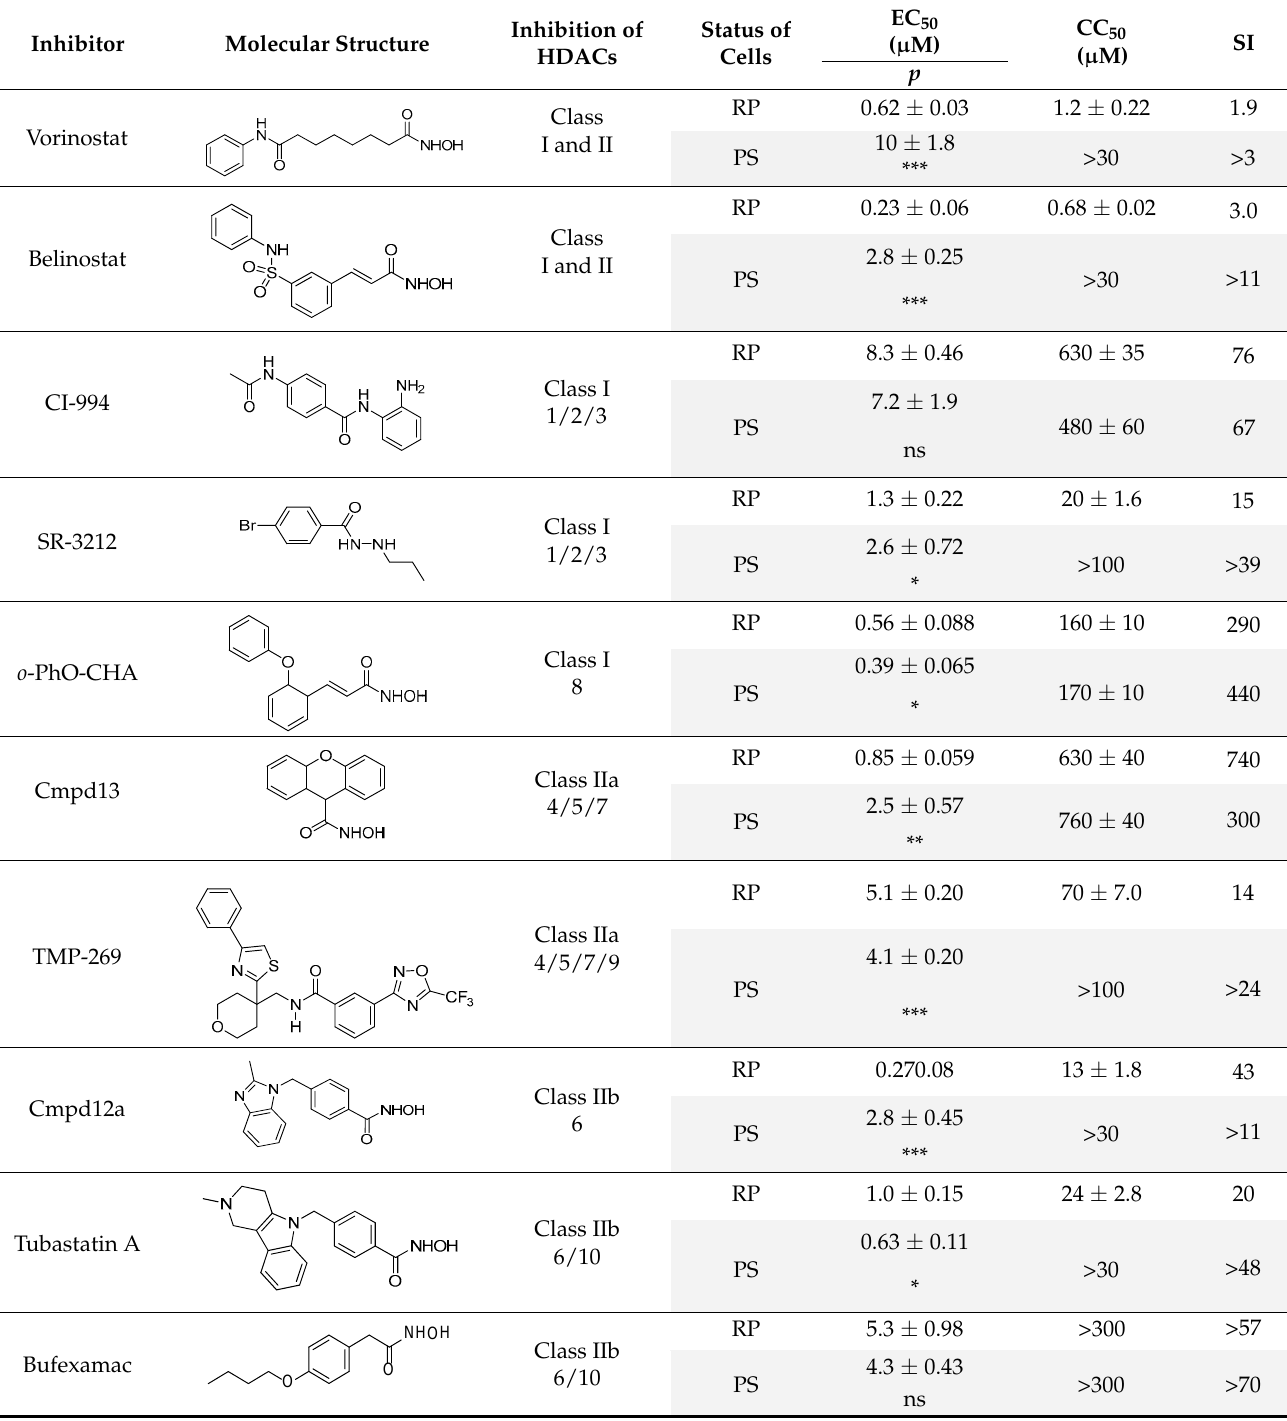
ing that the senescence status of the cells can significantly affect the antiviral potency of HDACi (Table 2). The dose response of replicon inhibition by CI-994 and bufexamac or ortho- PhO-CHA, TMP-269, and tubastatin A was the same or even more sensitive in the reprogrammed test system compared to the regular one, indicating that HDAC classes I/IIa/IIb (except HDAC6) remain vulnerable anti-HCV targets under pre-senescence con- ditions. It should be noted that the anti-HCV activities of SR-3212 and Cmpd13 decreased, Table 2. Testing of HTAs in regularly proliferating (RP) and in pre-senescent (PS) Huh7-luc/neo cells. Inhibitor Molecular Structure Vorinostat